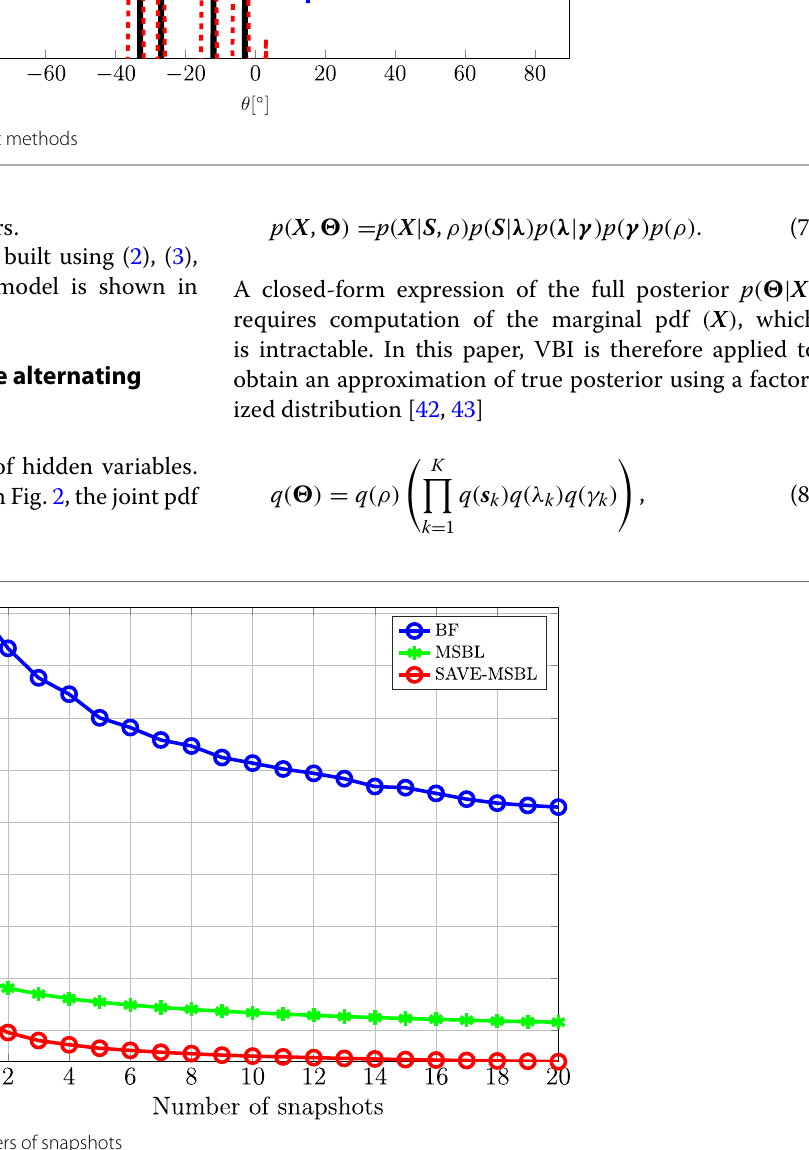
Fig. 4 Recovery accuracy with different numbers of